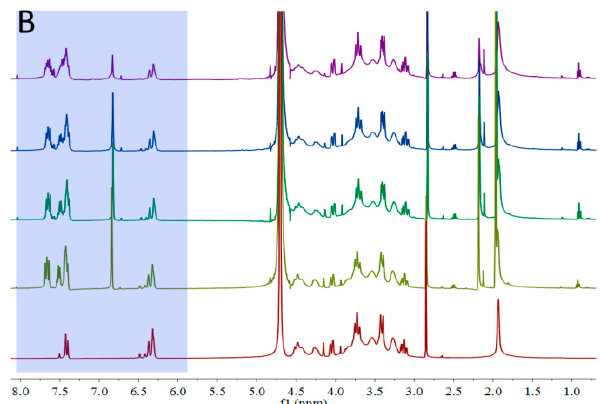
Figure 4. The 1 H NMR of HA-Furan with LAP under different illumination time. ( A ) Chemical shift between 6.1 ppm and 7.8 ppm; ( B ) Chemical shift between 1.0 ppm and 8.0 ppm.